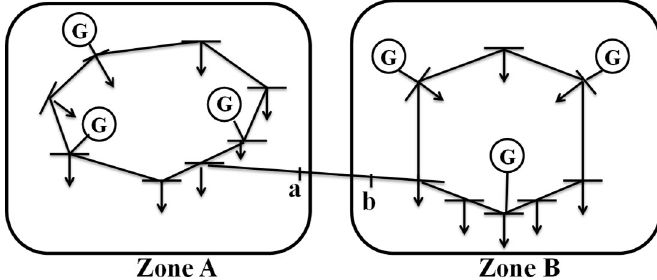
Figure 4. Congestion between two zones. (i) The G stands for a generator. The arrow indicates a load. The generator includes a solar thermal power station and the other types of generation (e.g., oil, coal, nuclear and renewable energy generation). (ii) Each zone consists of several different types of generators and loads. (ii) If the two zones are functionally separated by a capacity limit on an interconnection line, then a possible congestion may occur between them. End users in a zone cannot uses electricity generated by a solar thermal power station in the other zone.